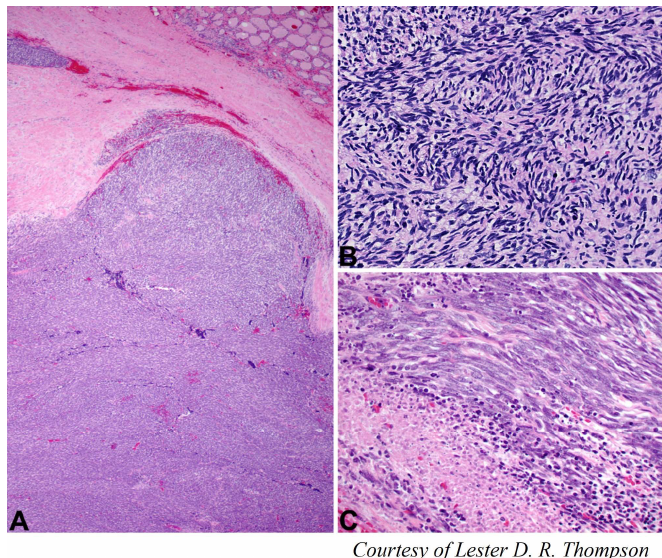
Figure 5. MPNST with a peritheliomatous growth pattern of the atypical spindle-cell neoplasm, showing buckled nuclei ( A ( × 200 magnification), B ( × 400 magnification)). Focus of necrosis showing buckled nuclei ( A (×200 magnification), B (×400 magnification)). Focus of necrosis (×200 ( × 200 magnification) ( C magnification) ( C ).